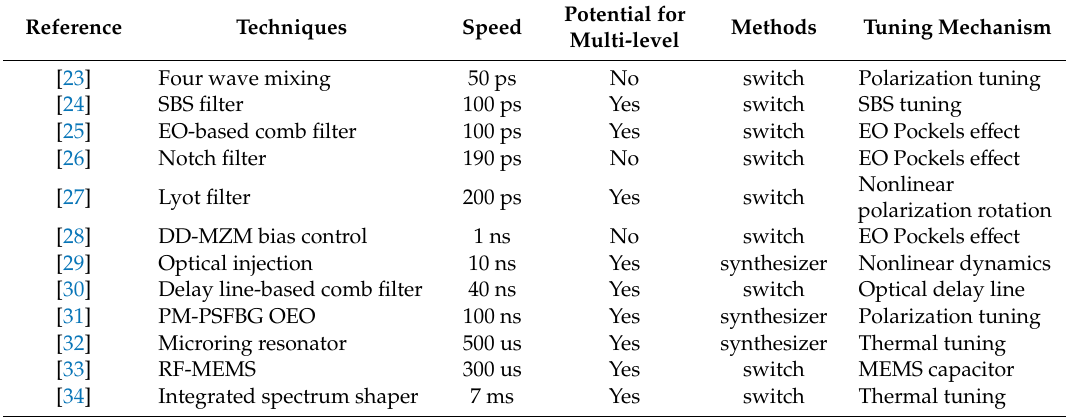
Figure 2. Schematic of microwave photonic frequency-hopping transmission systems. ( a ) Input— encoded data at baseband; ( b ) Ultrafast MWP-based frequency synthesizer controlled by an applied hopping pattern. ( c ) Frequency-hopping carrier generation using MWP RF switch ( d ) Output— frequency-hopping signal. Table 1. Comparison of the State-of-the-Art Frequency-Hopping Signal-Generation Schemes.